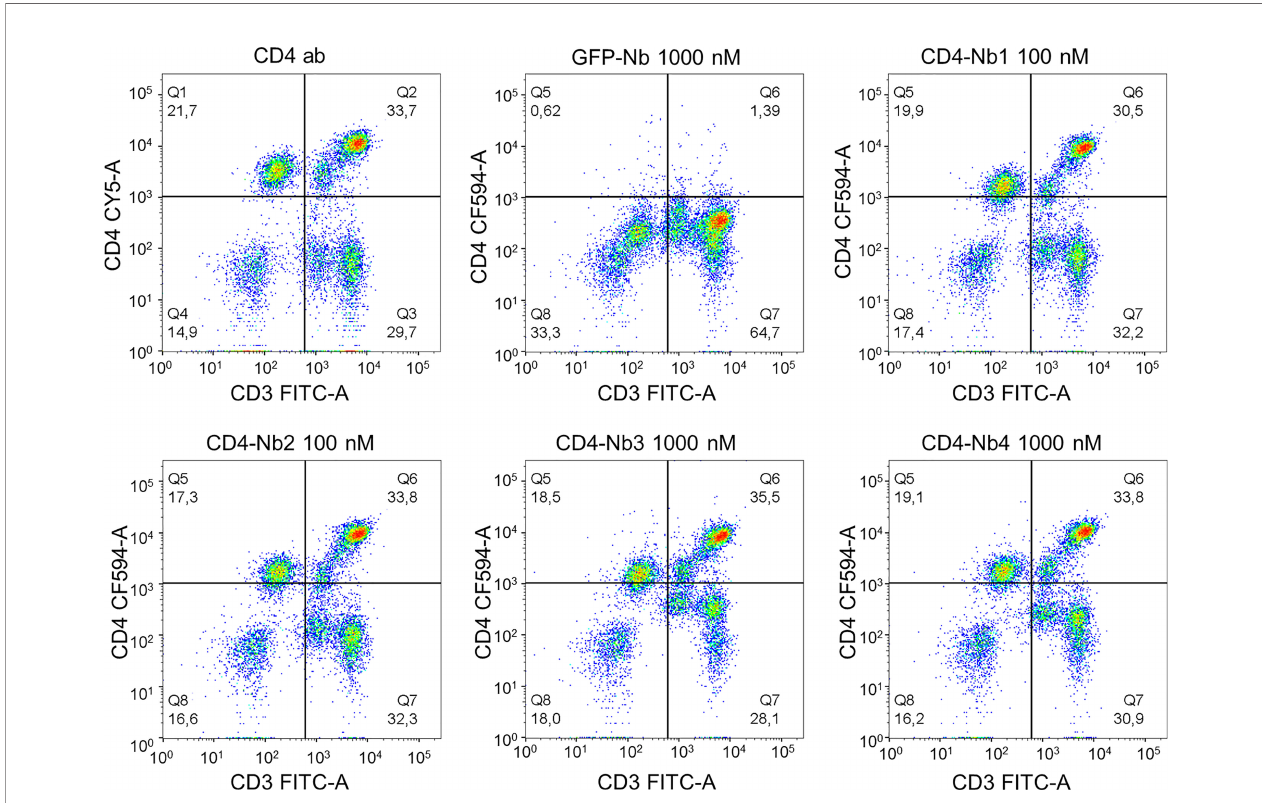
FIGURE 3 | Flow cytometry analysis of human peripheral blood mononuclear cells (PBMCs) stained with fl uorescently labeled CD4-nanobodies (Nbs). Schematic representation of the fi nal gating step for CD3 + CD4 + double-positive cells derived from donor